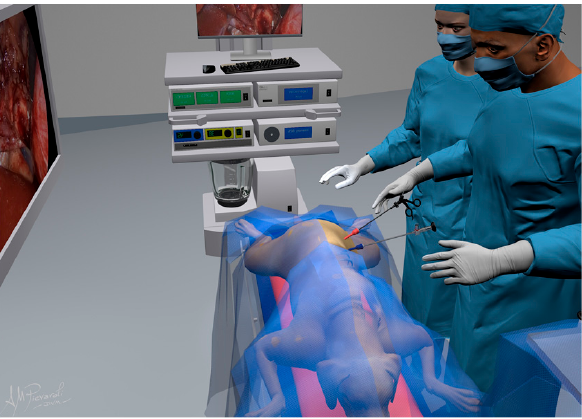
Figure 2. Instruments and dog positions are represented in the figure. The surgeon position is on the adrenal tumor side.